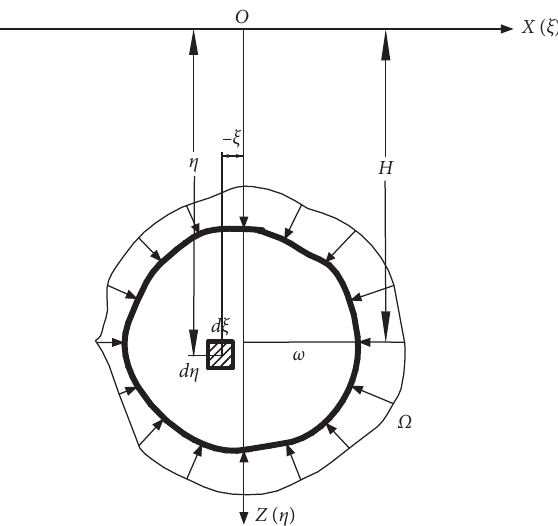
Figure 1: Ground loss of single tunnel excavation